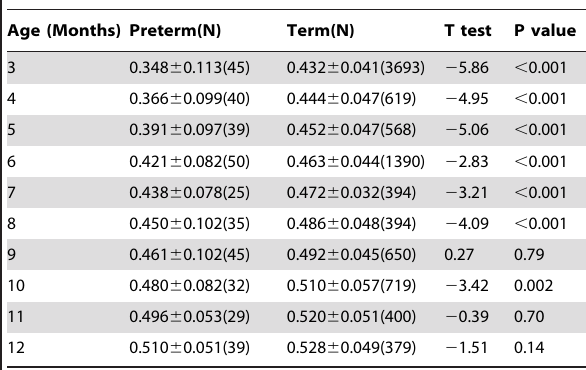
Table 4. Comparison of BMD values between term and gestational-age-adjusted preterm infants of 3 , 12 months (X 6 SD).